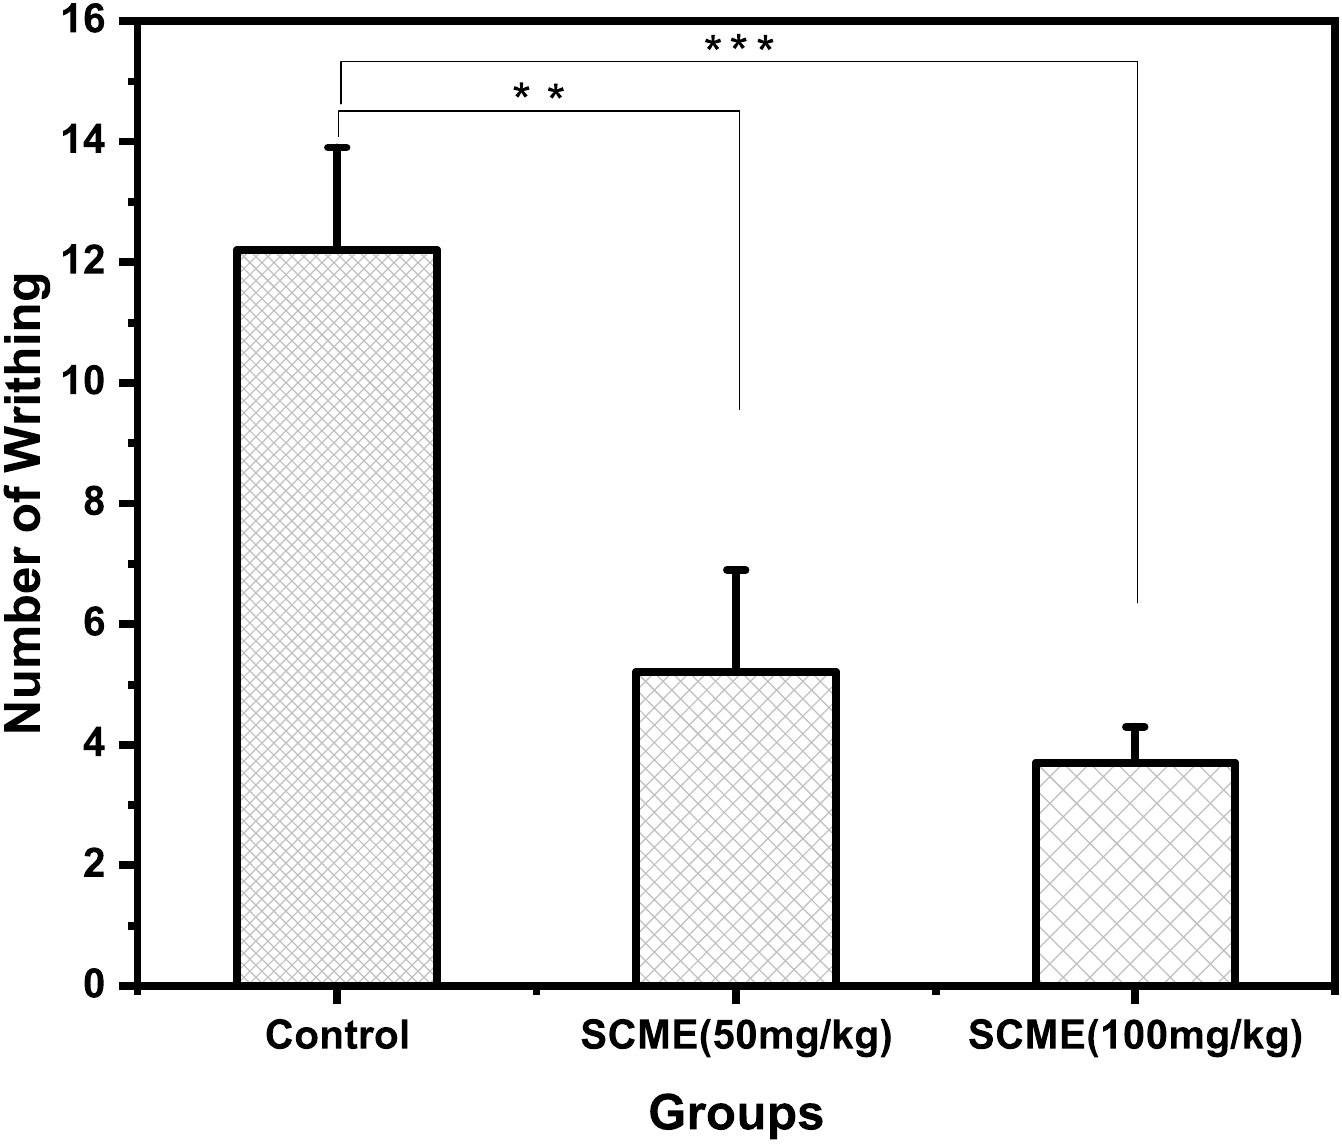
Fig 6. Analgesic effects of methanol extract of S . cumini leaves on acetic acid-induced writhing in rabbits. Values are taken in triplicates and expressed as Mean ± SEM (n = 3).